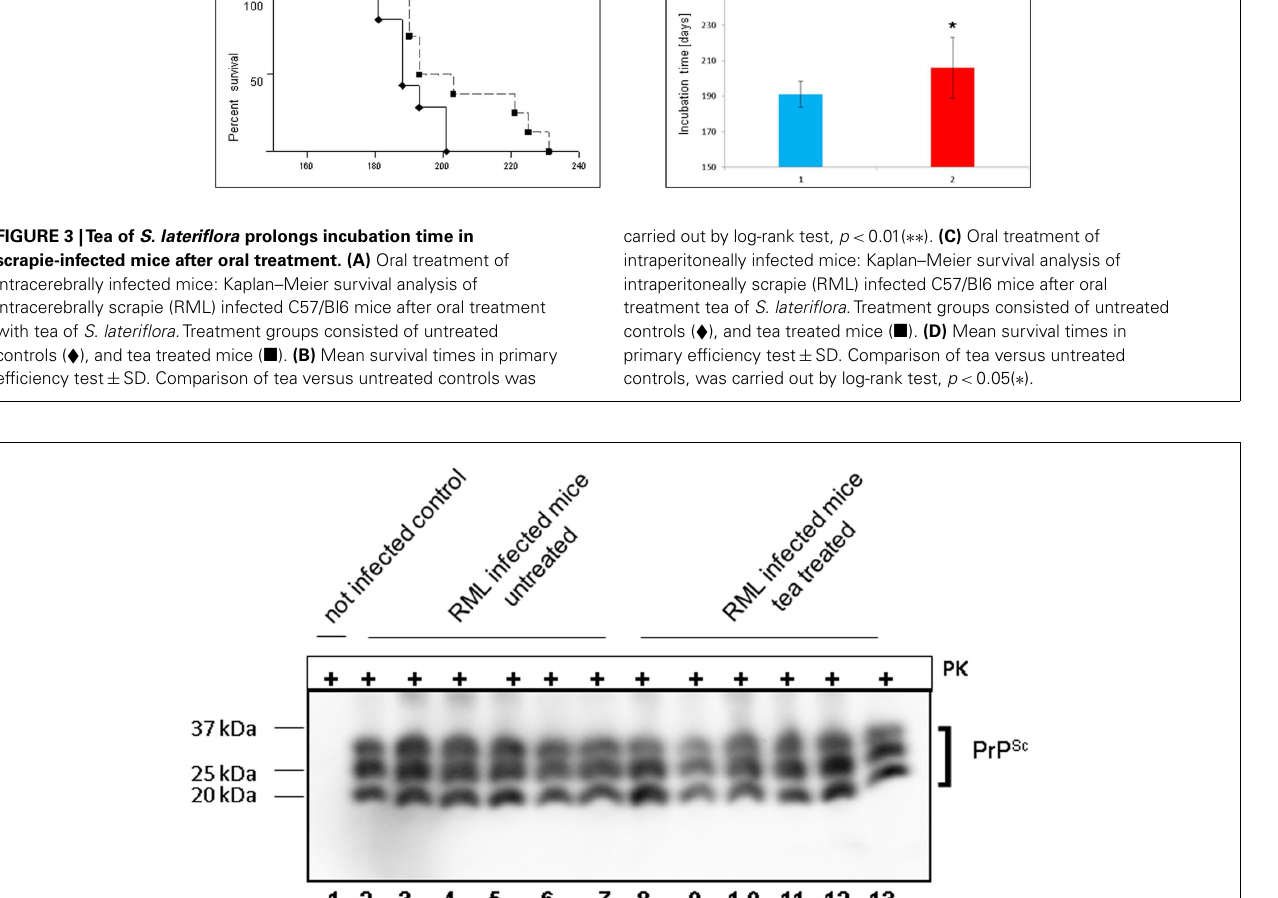
FIGURE 4 |Western blot analysis of sodium phosphotungstic acid precipitation of PrP Sc from brain homogenate of RML infected mice. Proteinase K digested and sodium phosphotungstic acid precipitated PrP Sc was detected by mab SAF-70. Lane 1 shows an uninfected control, lanes 2–7